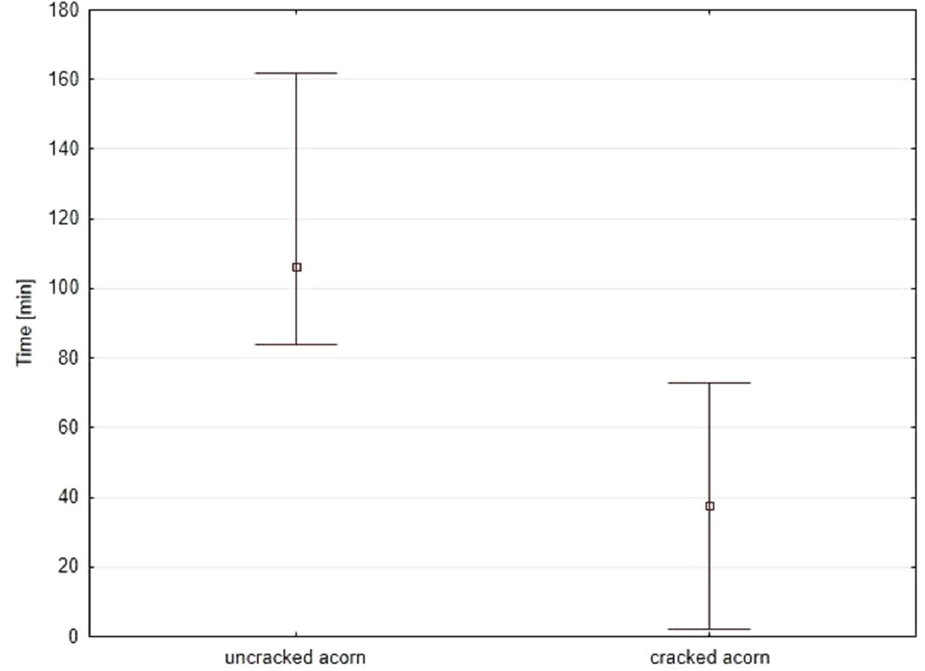
Figure 5. Time spent by females on drilling egg channels in uncracked vs. cracked acorns: squares — average time (median), whiskers — minimal and maximal duration.